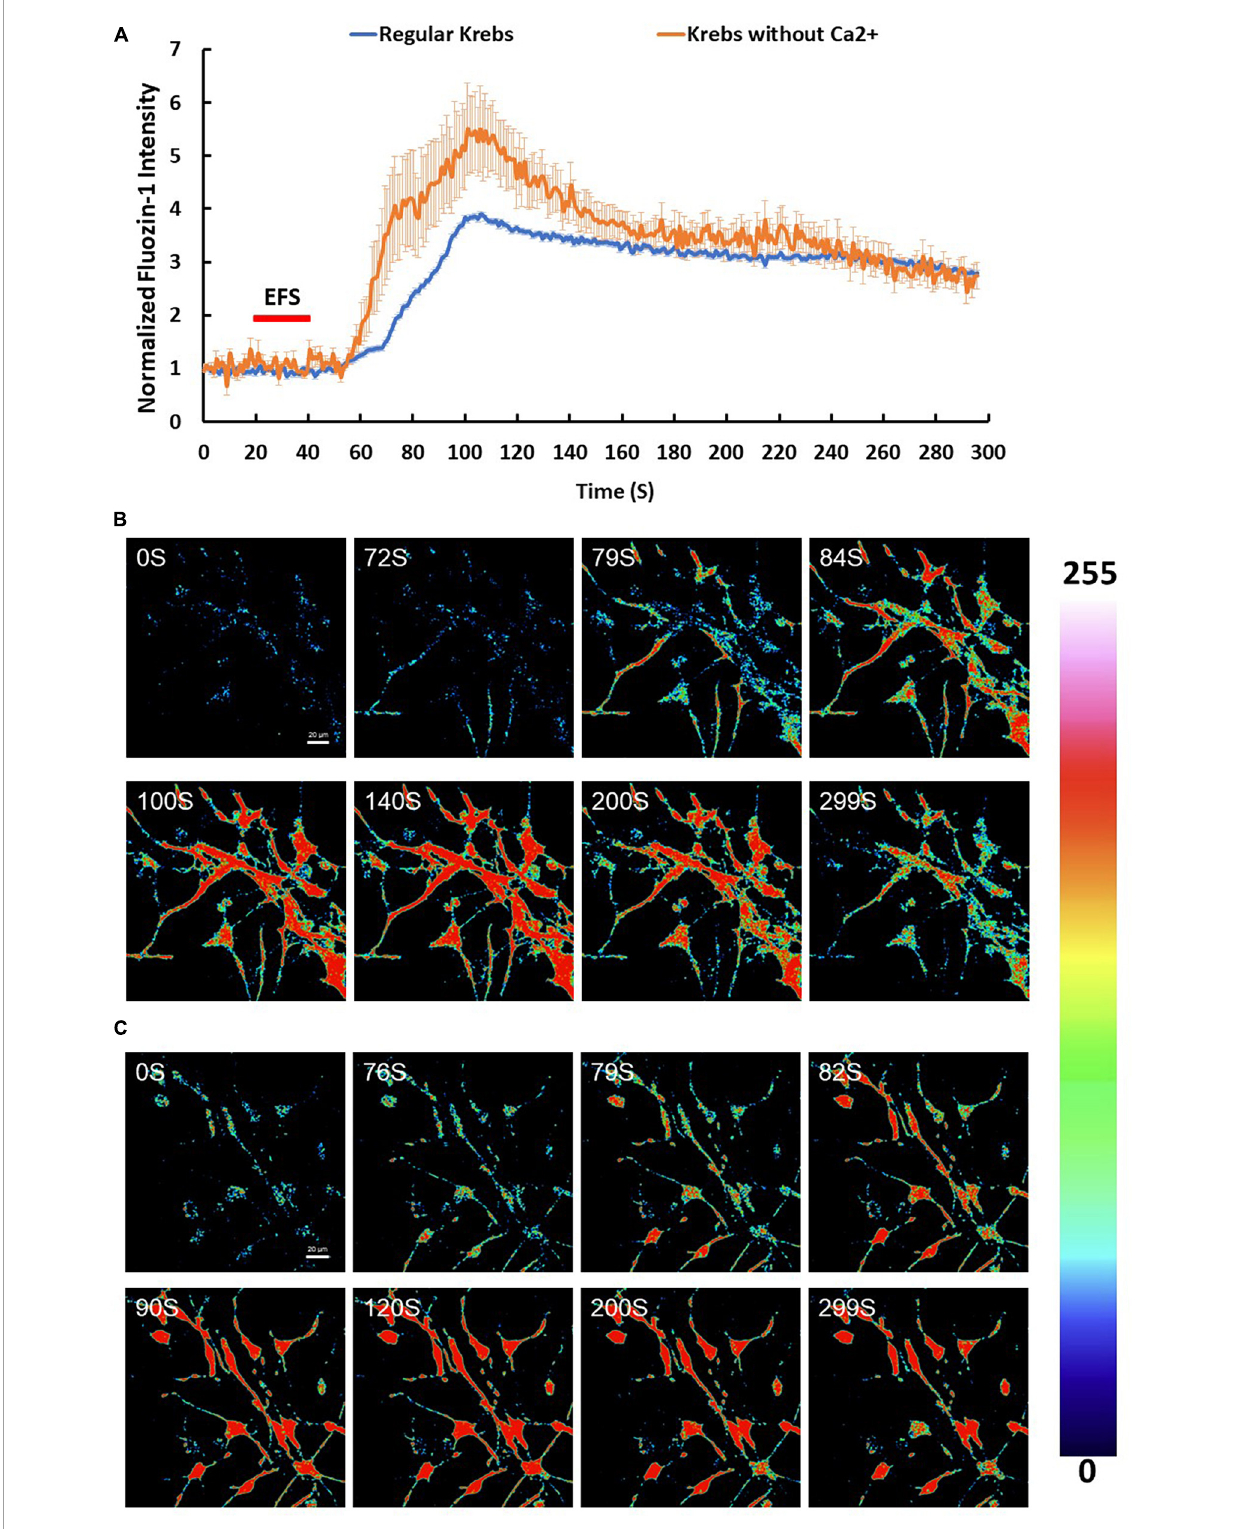
FIGURE4 Zinc (Zn 2 + ) changes in response to electric field stimulation (EFS). (A) Average intensity changes of Zn 2 + indicator Fluozin-1 AM in response to EFS in regular Krebs buffer (blue) and in Krebs buffer depleted from Ca 2 + (red). The EFS was applied at second 20 of the experiment for a duration of 20 s. Experiments were conducted in three independent brain preparations, each with three technical repeats. Data shown in (A) represent the average of three independent experiments and is expressed as normalized fluorescence intensity ratio relative to the averaged three images obtained prior to the addition of stimulus. (B,C) Sequential confocal images of Fluozin-1 AM labeled cortical cells at the indicated time intervals corresponding to before, during and after exposure to EFS with intensity of 7.69 V/cm (B) in regular Krebs buffer and (C) in Krebs depleted from Ca 2 + . Scale bar = 20 µ m. Intensity changes in (B,C) are color-coded whereby high levels are red and low levels are